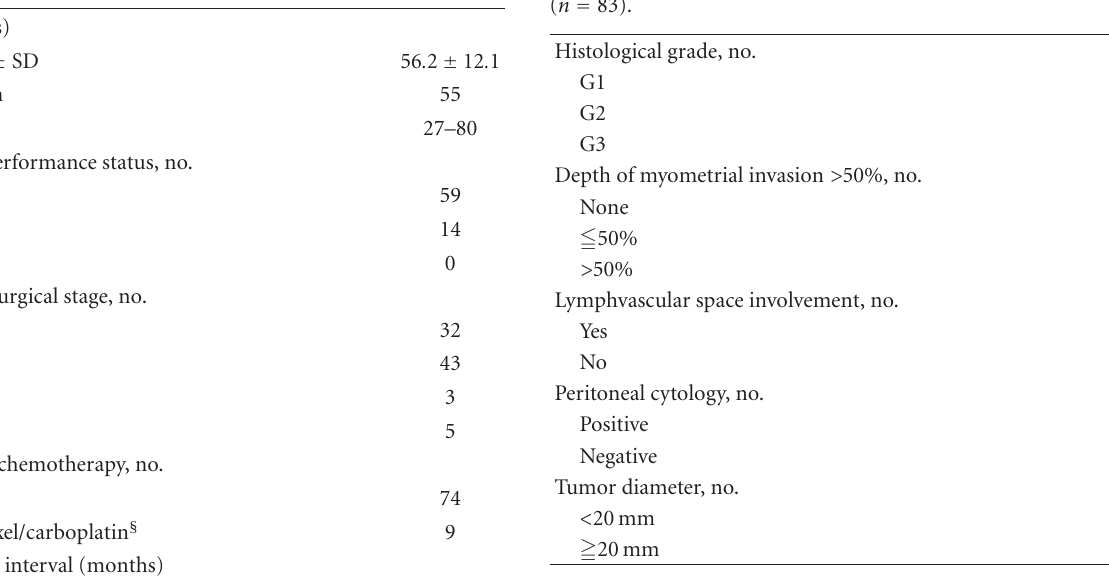
Table 1: Patients characteristics ( n = 83).